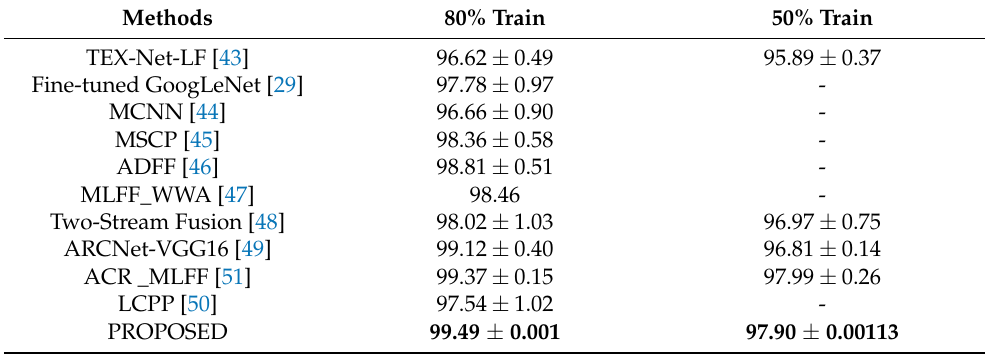
Table 3. Overall accuracy and standard deviation of the proposed method and comparison ap- proaches on the UC Merced data